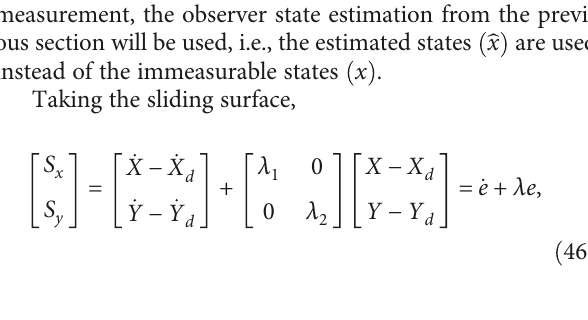
Figure 5: Robot trajectory around the X – Y